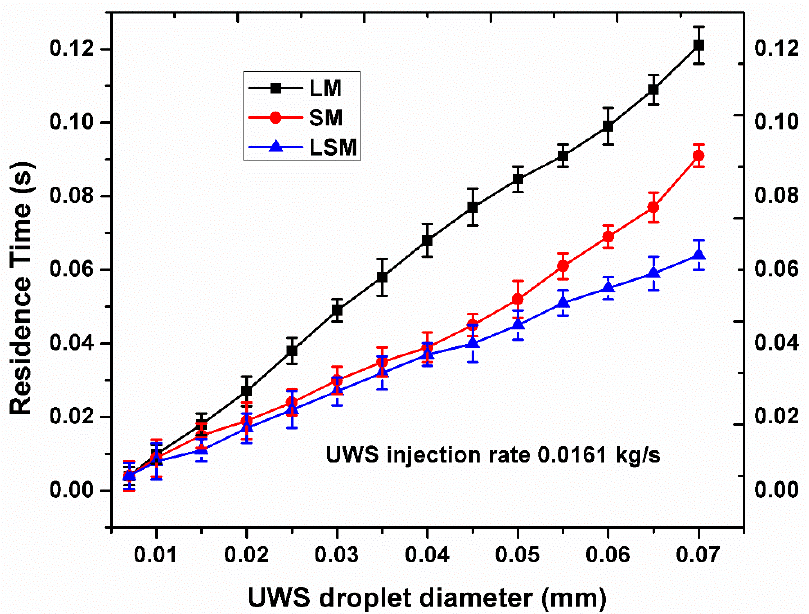
Figure 9. Residence time of urea droplets with the use of different mixers.